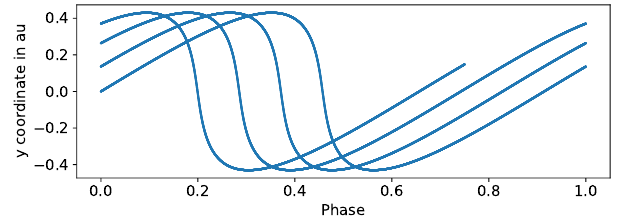
Fig. 111.— Phase plot, with an assumed periodicity of T = 0 . 8a, for our simulated orbit still see separate, similar curves shows that we have